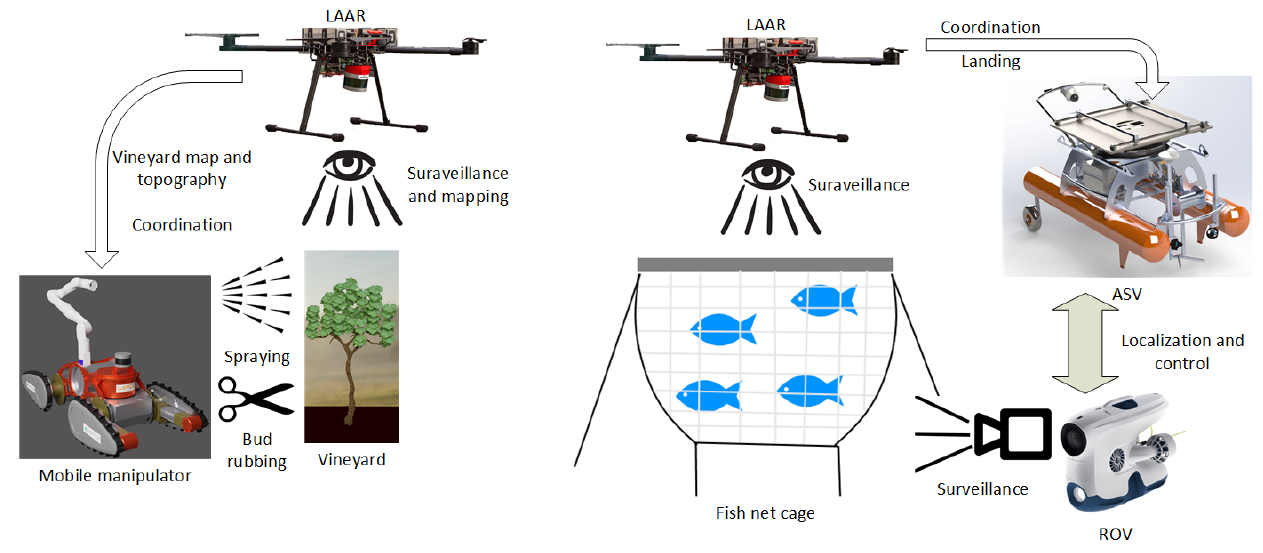
Figure 1. HEKTOR system overview. Viticulture scenarios: vineyard surveillance, protective spraying and suckering with an all-terrain mobile manipulator (ATMM) and a light autonomous aerial robot (LAAR). Mariculture scenarios: coordinated monitoring of fish net pens from below and from the air using the LAAR, an autonomous surface vehicle (ASV), and a remotely operated underwater vehicle